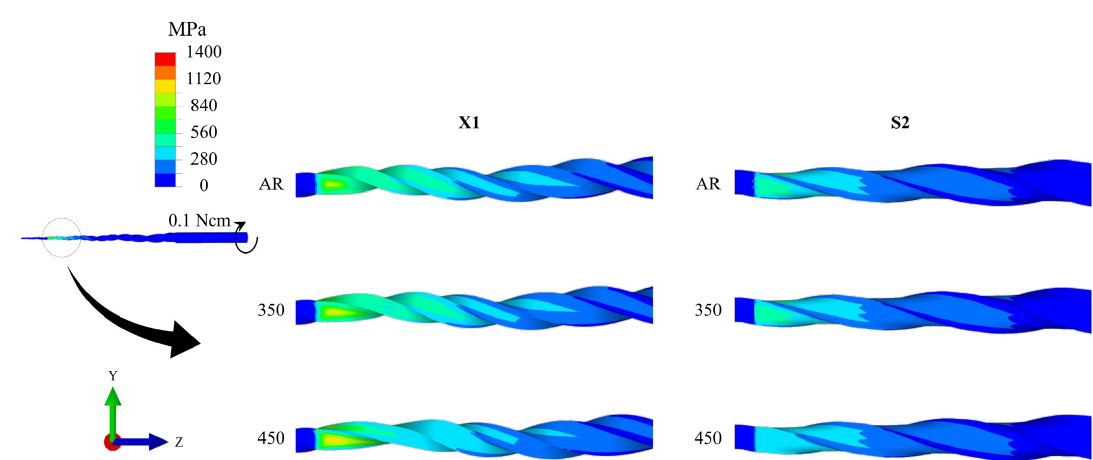
Figure 8. The von Mises stress distribution along with the body instruments under torsion at 0.10 Ncm clockwise.